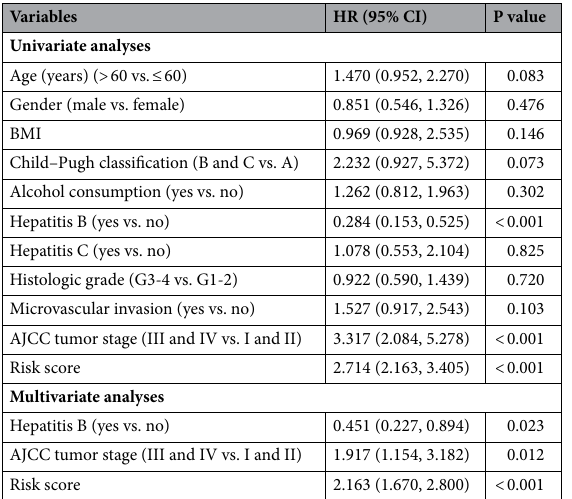
Table 3. Univariate and multivariate analyses of risk factors with and OS in the training cohort. HR, hazard ratio; CI, confidence interval; OS, overall survival; BMI, body mass index; AJCC, American Joint Committee on Cancer.